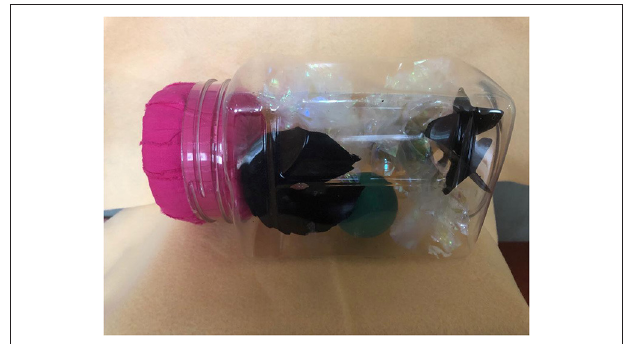
FIGURE 1 | D&E simulation model made with 32 oz plastic container as uterus; mylar balls and flexible darts as “fetal